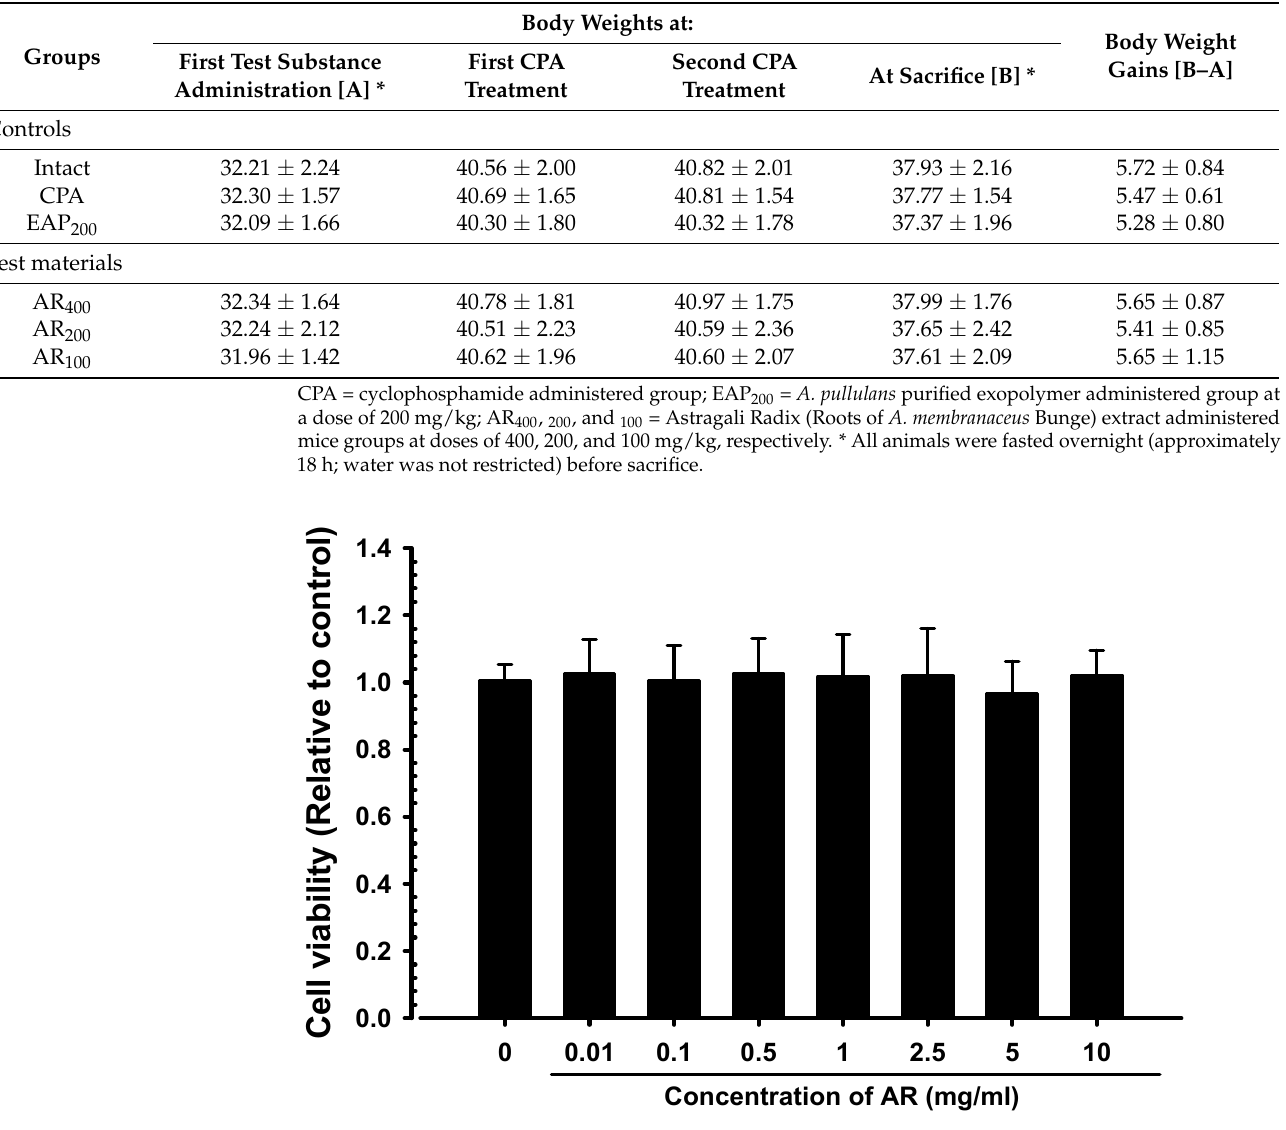
Figure 2. Effects of AR on the normal splenocytes’ viability. Values are expressed as means ± S.D. of six independent experiments; AR = Astragali Radix (Roots of A. membranaceus Bunge) extract; cells were treated with 0 (control), 0.01, 0.1, 0.5, 1, 2.5, 5 and 10 mg/mL of AR dissolved in media and incubated for 72 h.